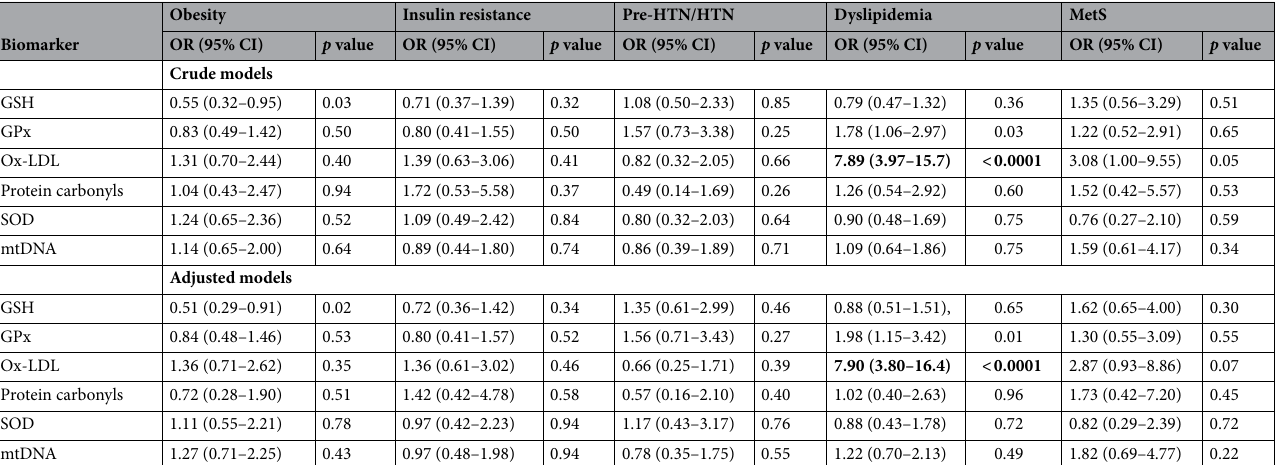
Table 4. Associations between biomarkers of oxidative stress and cardiometabolic complications in survivors of childhood acute lymphoblastic leukemia: crude and adjusted models. The crude and adjusted models were assessed between each biomarker and each cardiometabolic outcome. Models were adjusted for CRT exposure, age at diagnosis, time since diagnosis and sex. Odds ratio (non-corrected 95% CI) and p-value are indicated for each association. Significant associations are in boldface. Bonferroni-adjusted alpha = 0.05/number of biomarkers = 0.05/6 = 0.008. Metabolic syndrome was defined according to the International Diabetes Federation. CI: confidence interval; CRT: cranial radiotherapy; GPx: glutathione peroxidase; GSH: glutathione; HTN: arterial hypertension; MetS: metabolic syndrome; mtDNA: mitochondrial DNA; Ox-LDL: oxidized low- density lipoprotein; SOD: superoxide